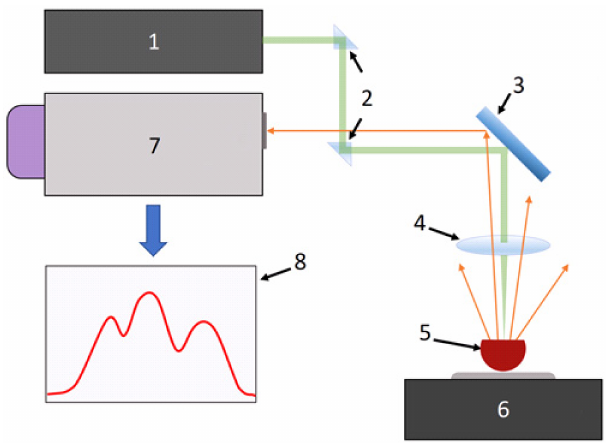
Figure 3. Scheme of an experimental setup based on pulsed fluorescence spectroscopy: 1—laser, 2 —prisms, 3—Al mirror, 4—lens, 5—the sample, 6—motorized stage, 7—spectrograph with intensified CCD ICCD camera, 8—fluorescence